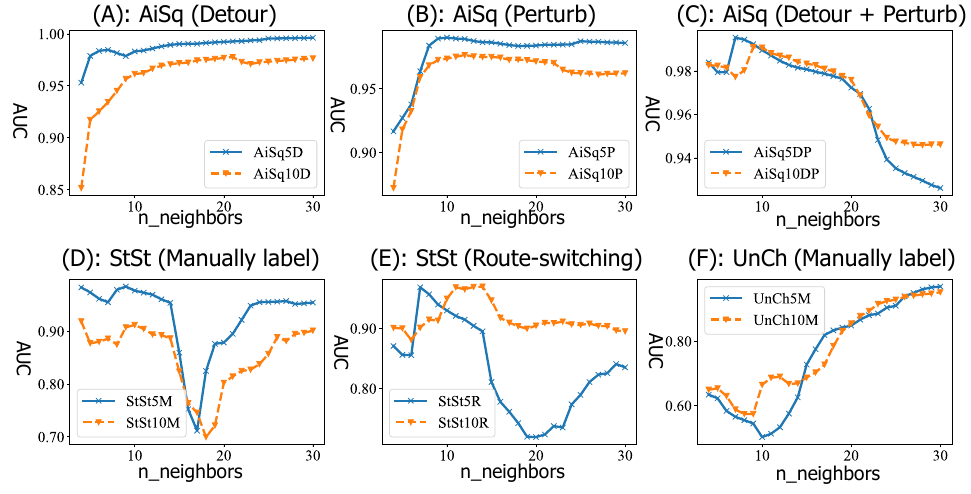
Figure 9. The effect of n _ neighbor for LOF: outlier types matter. Another interpretation was to plot both k and n _ neighbor on the same diagram as shown in Figure 10. This led to two important deductions. First, good results (yellow color) were always obtained when both k and n _ neighbor were larger. Second, the distance between the source and the destination affected the stability of the results by visualizing the scatters of